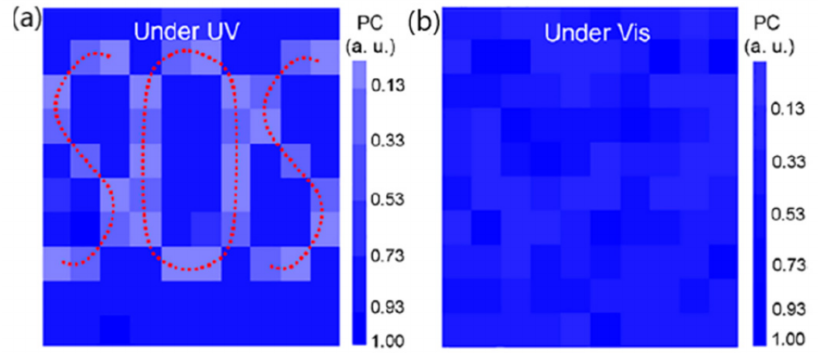
Figure 19. The visibility of the “SOS” characters under ( a ) UV light, ( b ) Vis light. Reprinted with permission from ref. [155]. Copyright 2019 American Chemical